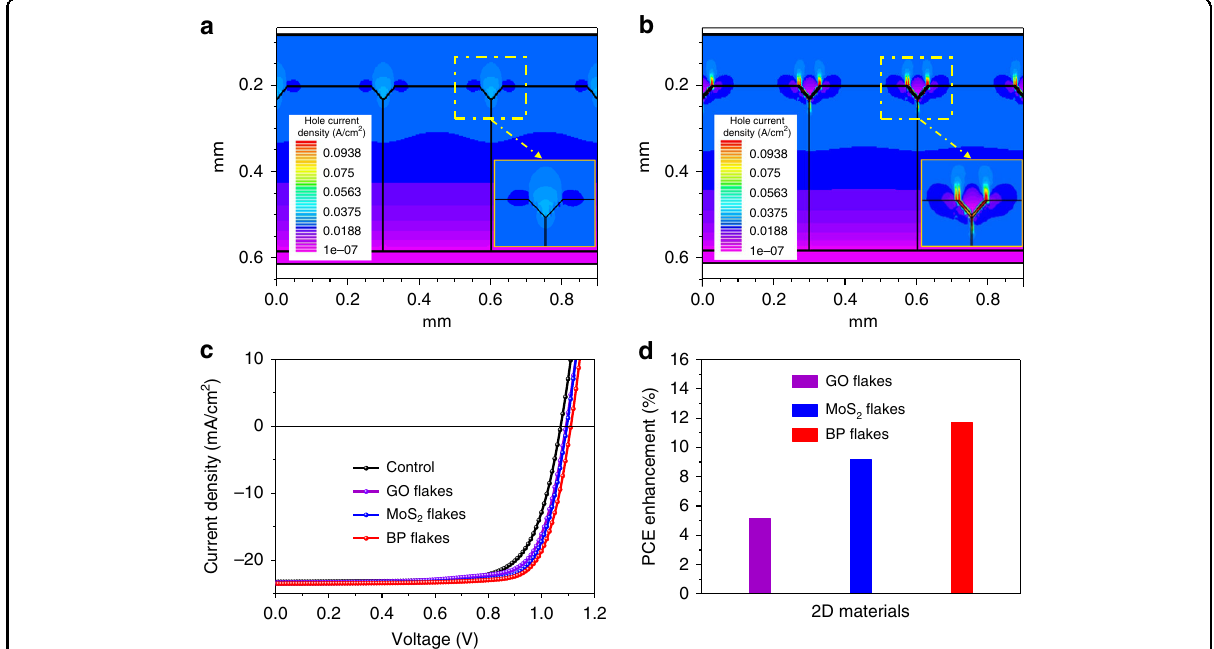
Fig. 5 Device simulation results of the MAPbI 3 PSCs. a , b Hole current density distribution of the simulated PSCs without ( a ) and with ( b ) the BP modi fi cation. c Simulated J – V curves of the PSCs modi fi ed with different 2D materials. d Relative PCE enhancement of the PSCs after modi fi cations with different 2D